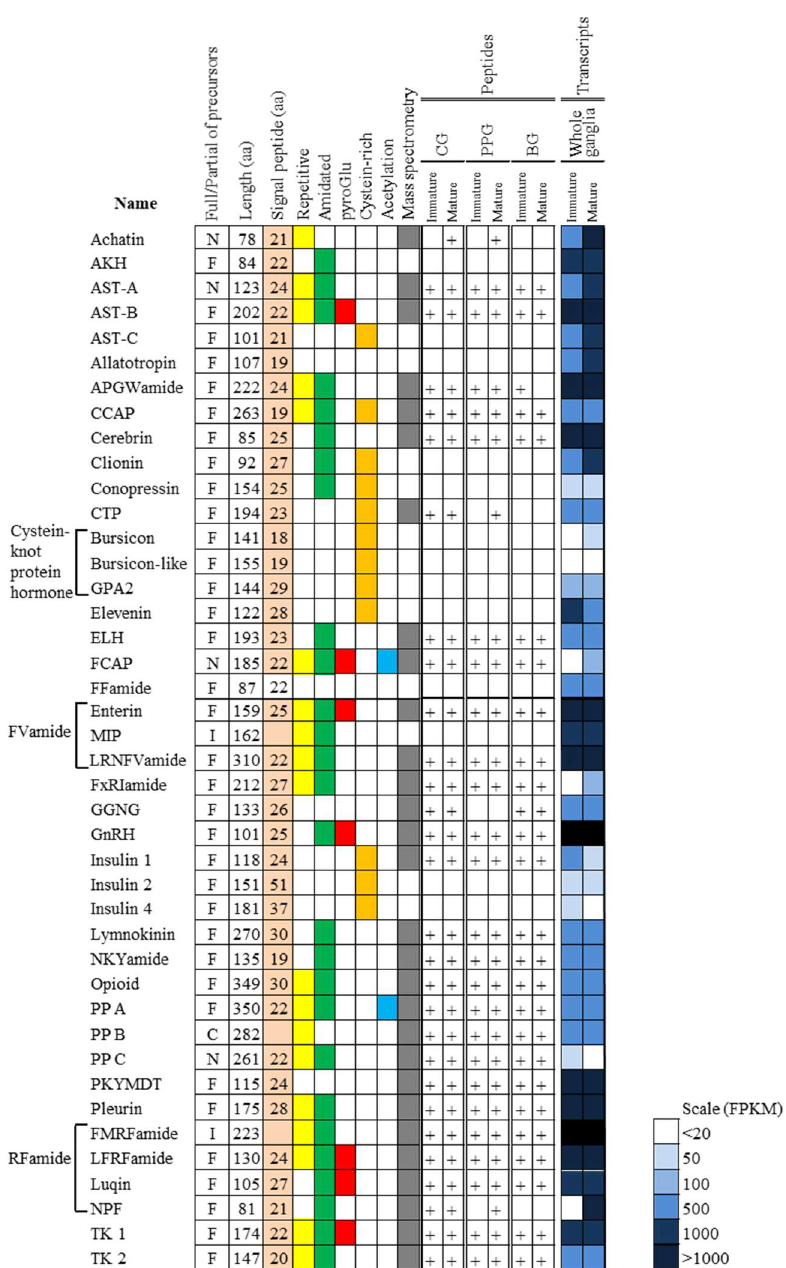
Figure 5. Characteristics of neuropeptide precursors and expression patterns of peptides and transcripts identified from Haliotis discus hannai . Shading on signal peptide, repetitive, amidated, pyroGlu, Cysteine-rich and acetylation squares indicates the characteristic of neuropeptide structures. White cells indicate an absence of the neuropeptide or precursor transcripts. “ + ” represent the neuropeptide was positively detected in the corresponding sample. FPKM in immature and immature ganglia are color-coded as described in legend. Peptide family abbreviations; AKH, Adipokinetic hormone; AST-A, A-type allatostatin or buccalin; AST-B, B-type allatostatin or WWamide; AST-C, C-type allatostatin; CCAP, Crustacean cardioactive peptide; GPA2, Glycoprotein A2; CTP, Calcitonin-like peptide; ELH, Egg laying hormone; FCAP, Feed circuit activating peptide; GnRH, Gonadotropin-hormone; MIP, Mytilus inhibitory peptide or PXFVamide; PP, Pedal peptide; TK, Tachykinin. Deduced protein type abbreviations: F, full-length; I, internal fragment protein; N, amino-terminal partial protein, C, carboxyl-terminal partial protein.